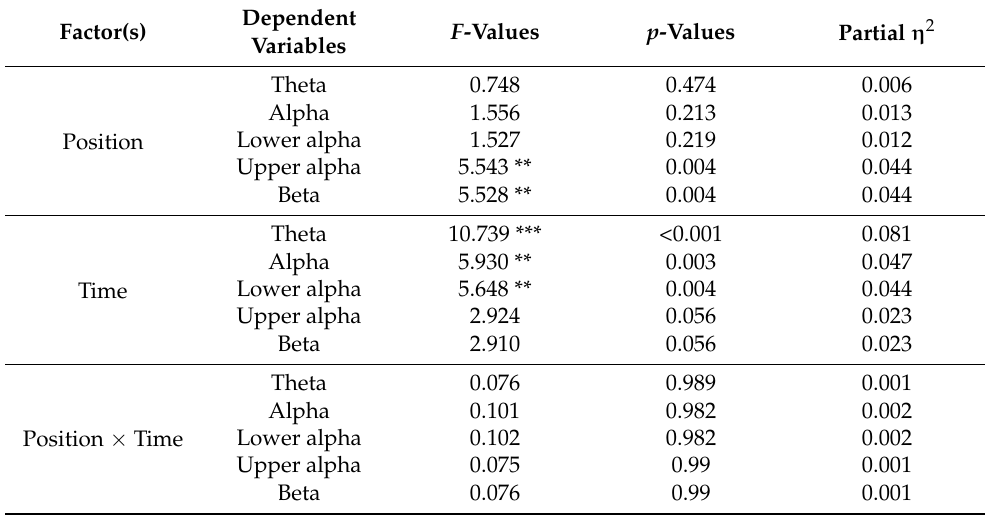
Table 1. Summary of ANOVA with factors: channel and stimuli for theta, lower alpha, upper alpha, and beta bands.